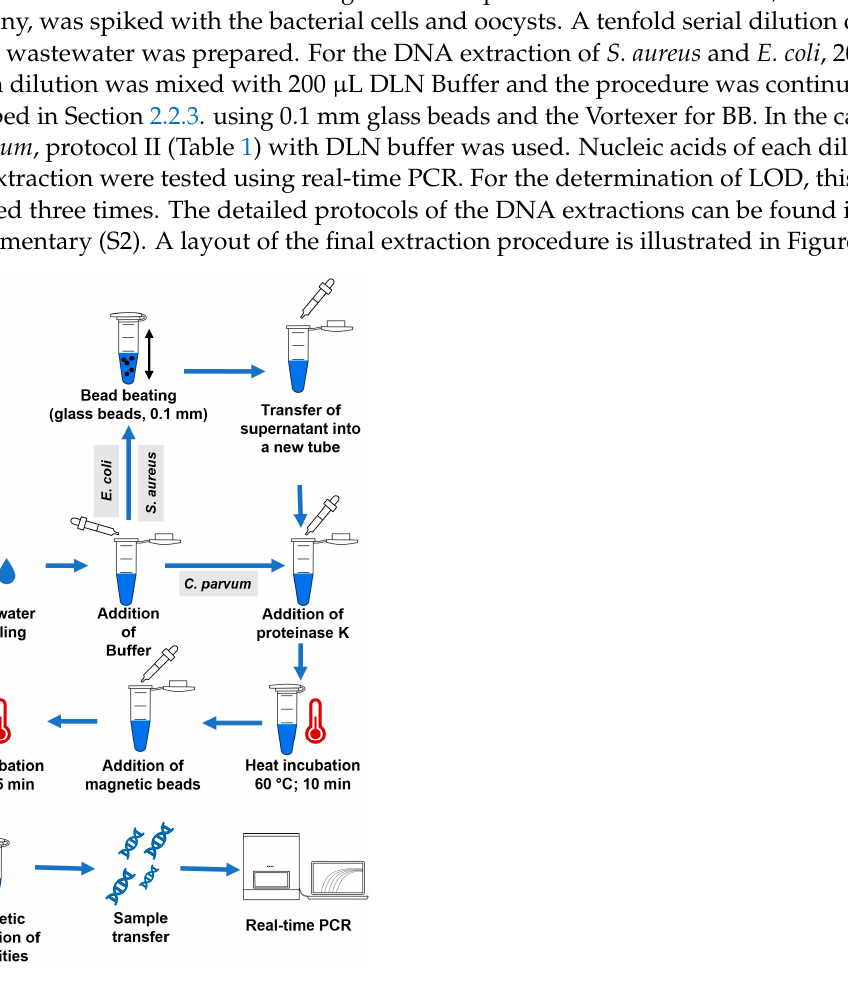
Figure 1. Flowchart of the rapid extraction method selected for determining the limit of detection for S. aureus , E. coli and C. parvum .